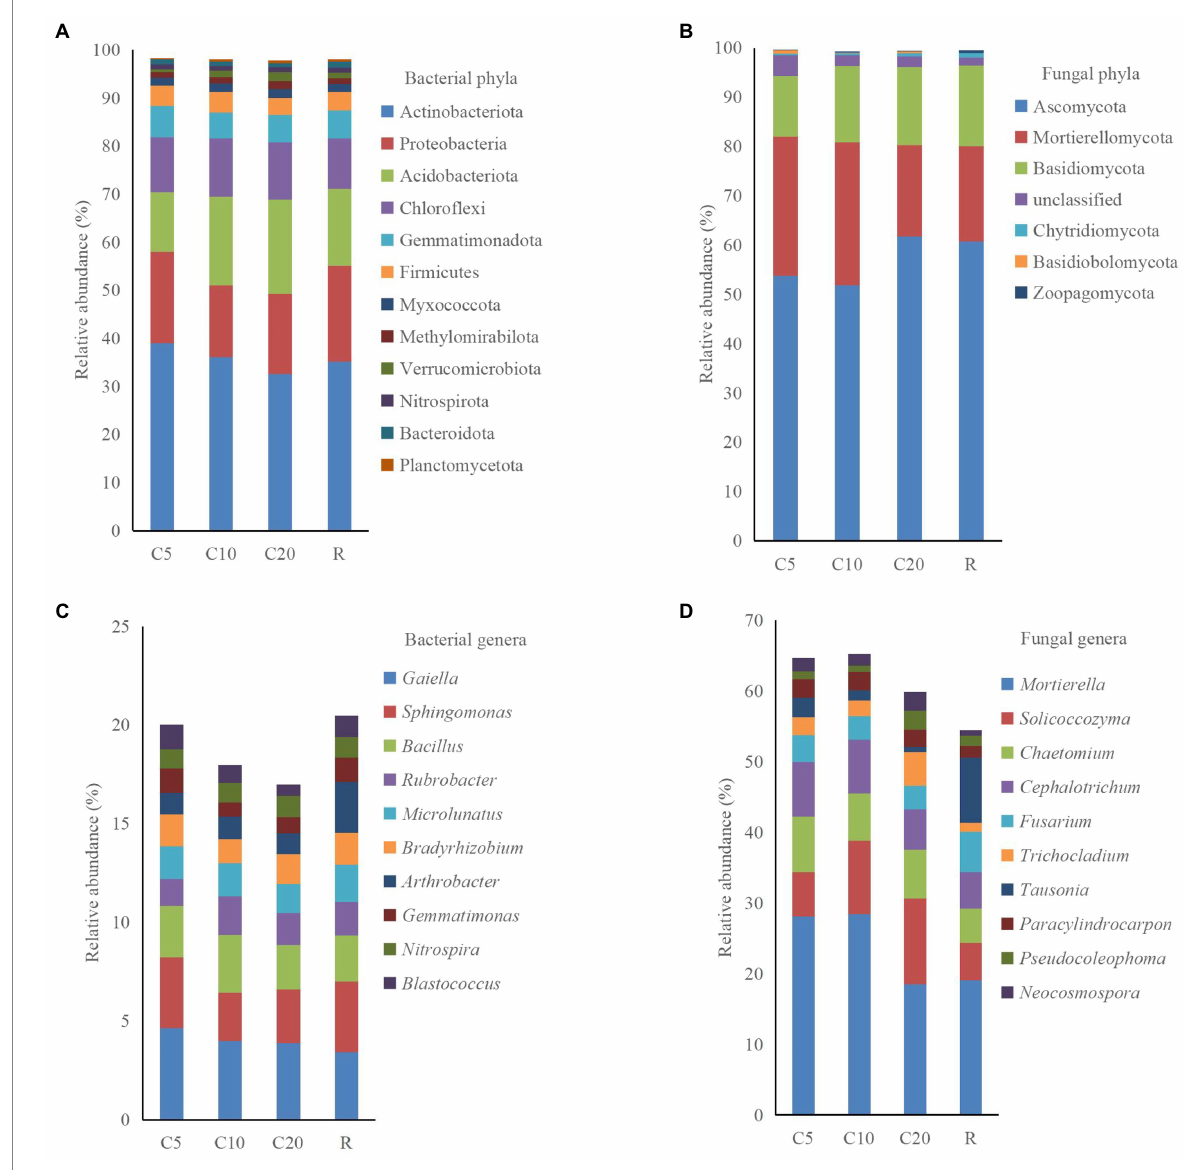
FIGURE 2 Relative abundance of dominant phyla and genera (top 10 except unclassified taxa) of soil bacteria and fungi. C5, C10, and C20 represent soybean continuous cropping treatments for 5, 10, and 20 years, respectively, and R represents soybean-corn rotational cropping treatment. (A) Bacterial phyla, (B) Fungal phyla, (C) Bacterial genera, and (D) Fungal